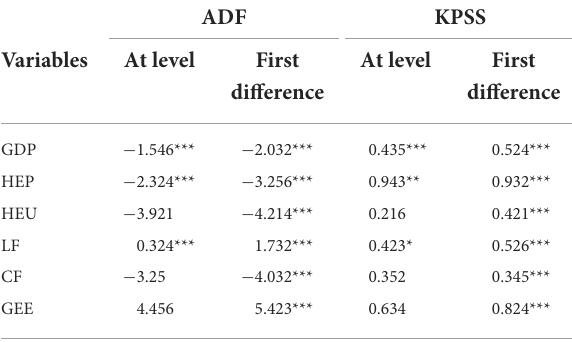
TABLE 2 Exploring variable integration order with ADF and KPSS testing.